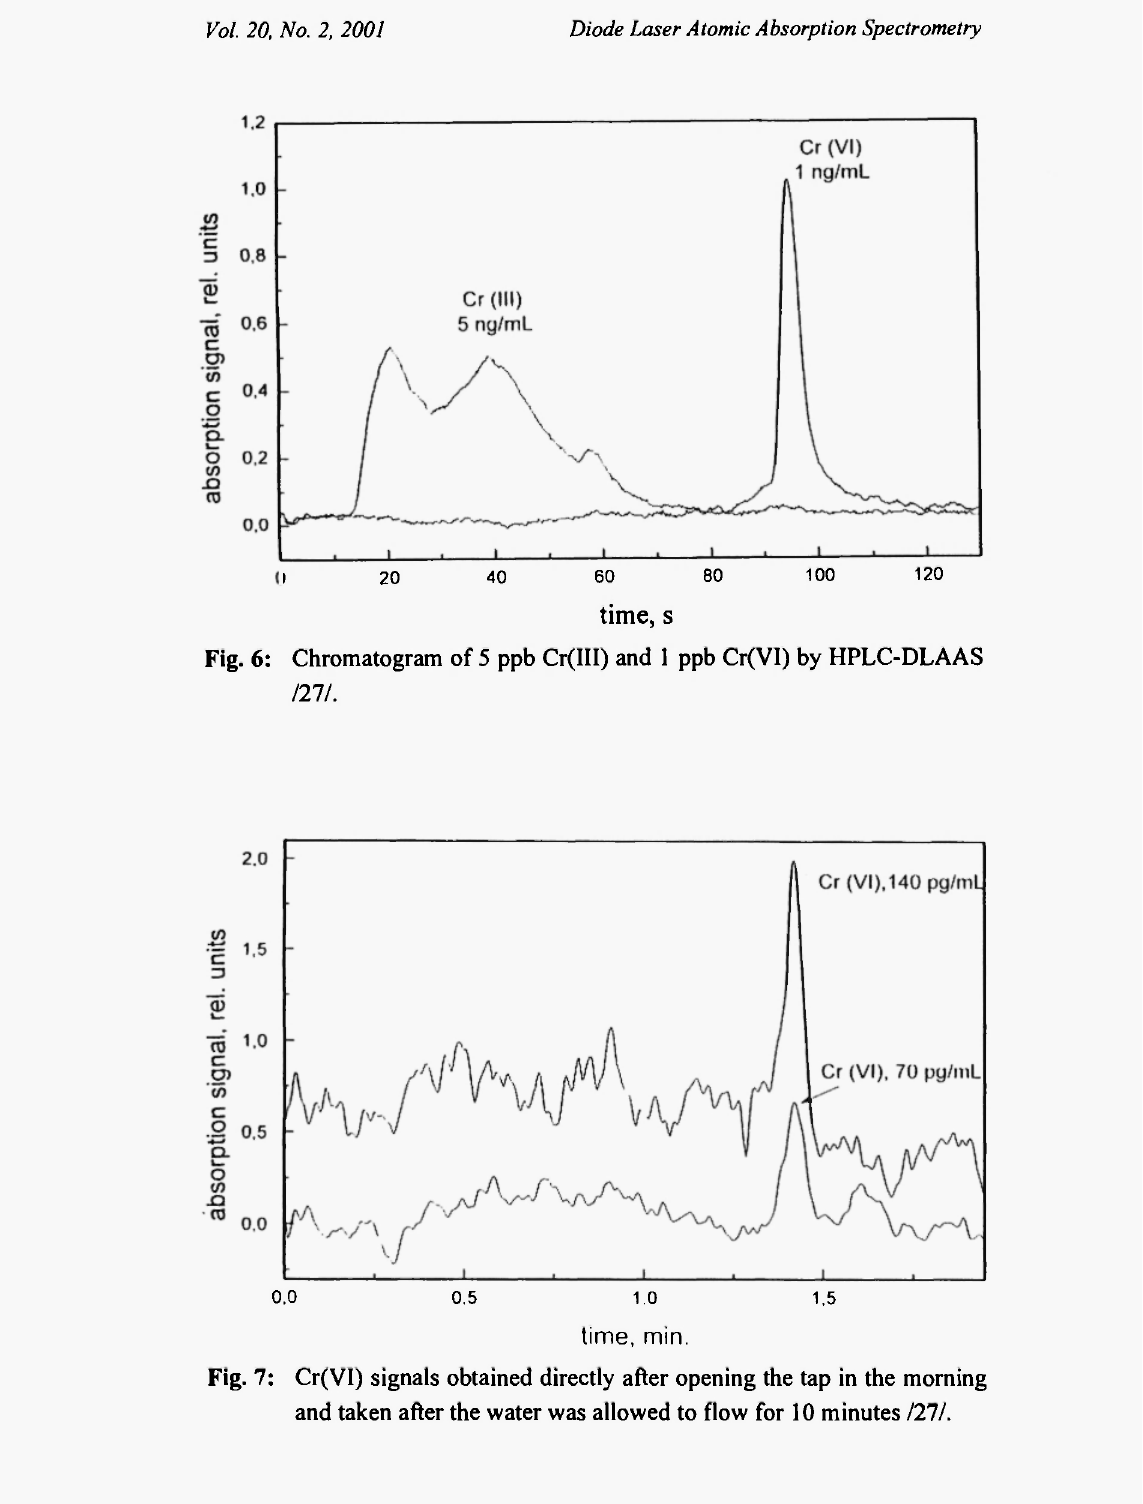
Fig. 7: Cr (VI) signals obtained directly after opening the tap in the morning and taken after the water was allowed to flow for 10 minutes